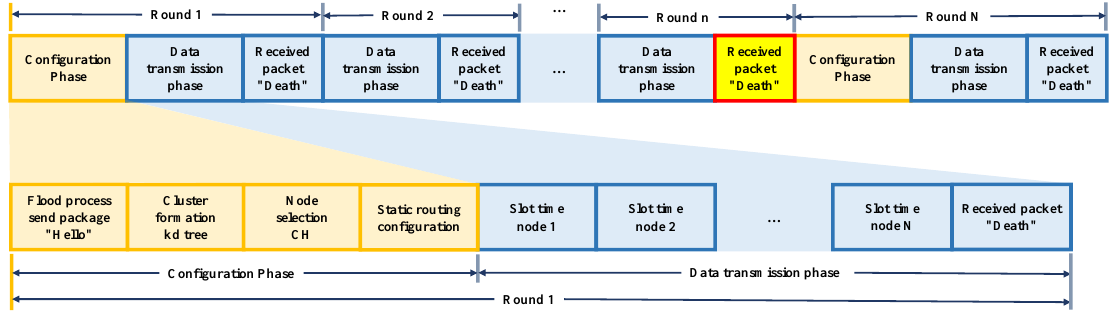
Figure 8. Protocol header H-kdtree.